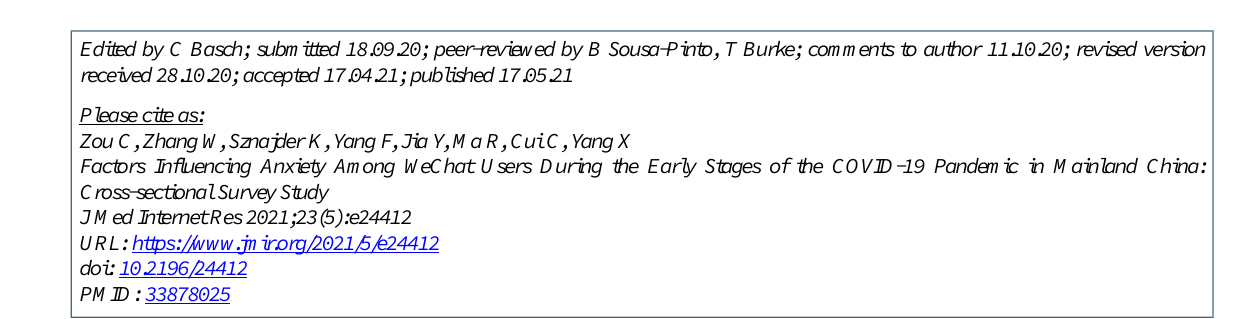
SARS: severe acute respiratory